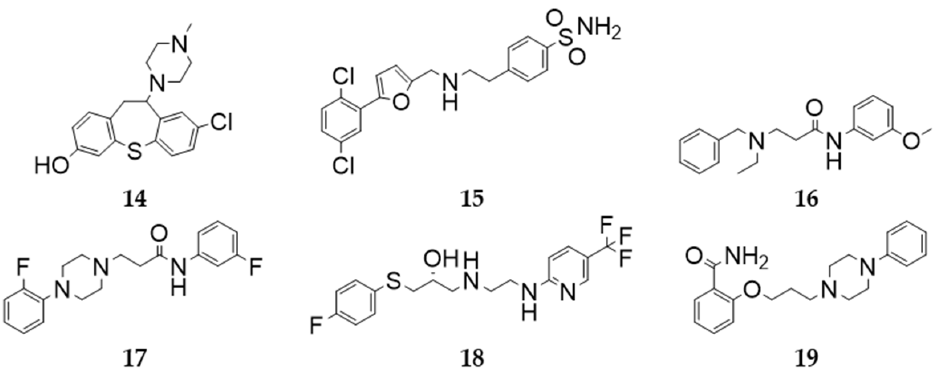
Figure 7. Two-dimensional structures of the compounds selected for in vitro K I determination.